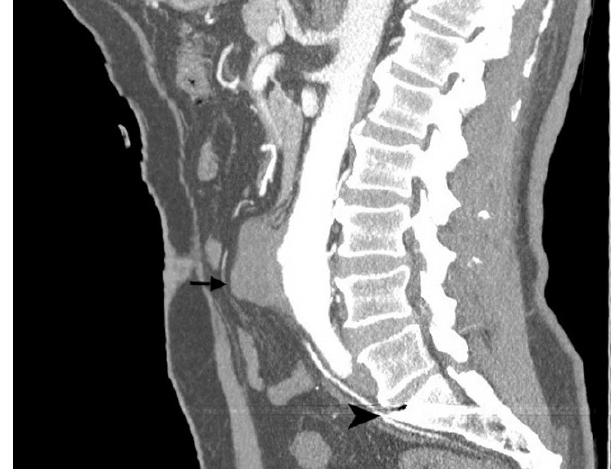
Figure 2 - Computed tomography in the sagittal plane shows the pseudoaneurysm in the anterior aortic portion (arrow) and a metalic fragment impacted in S1